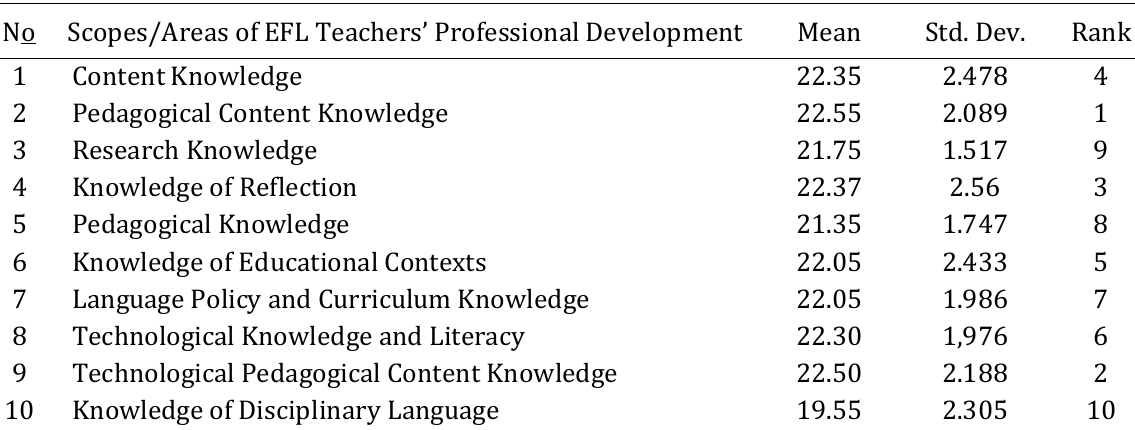
Table 6. EFL Teachers’ Reflection/Feedback on the Curr ent Professional Development